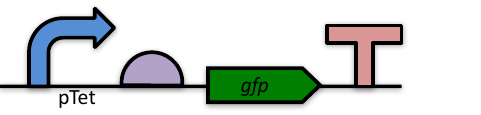
Figure 28: DNA sequence for a functional unit in which the pTet promoter and an anonymous ribosome entry site regulate expression of a coding sequence for GFP, ended by a terminator.